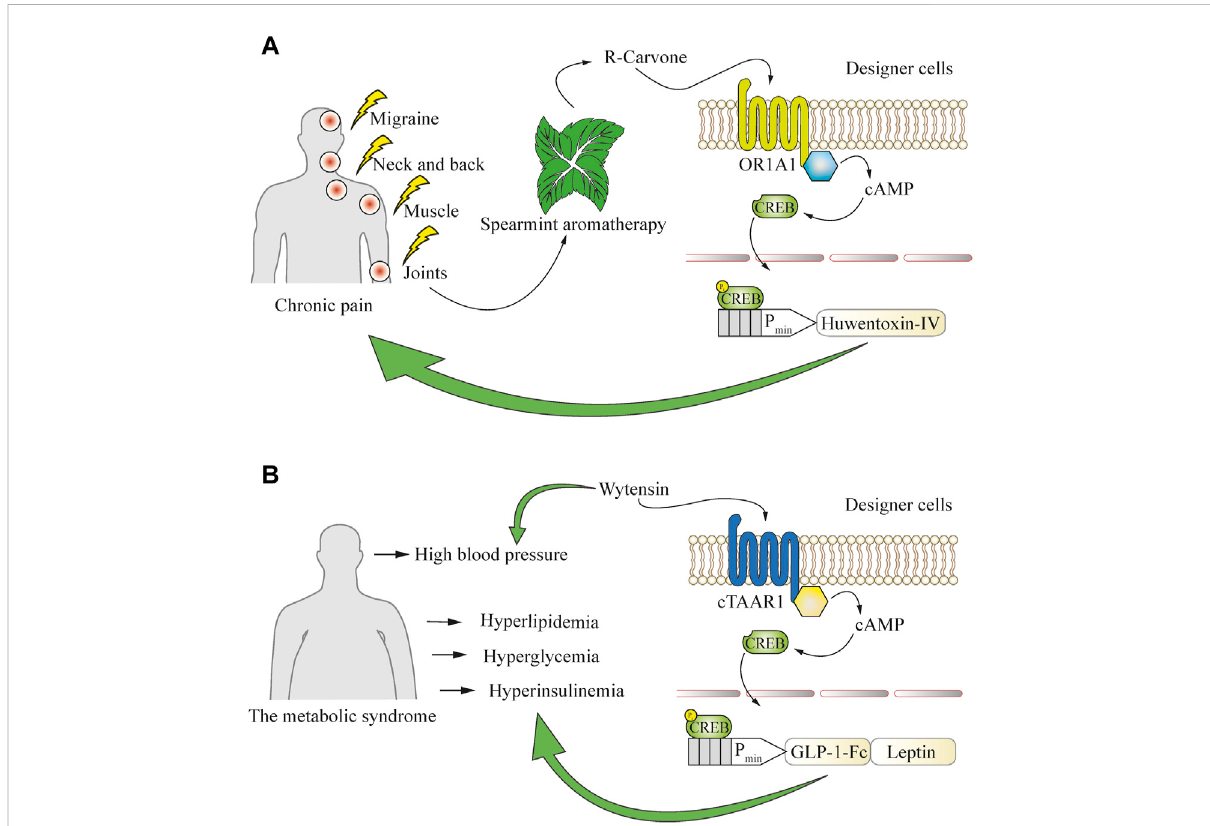
FIGURE 5 Using a de fi ned behavior to convert open-loop cellular systems into closed-loop circuits. (A) Application of aromatherapy for the treatment of chronic pain can be used to drive closed-loop production of an analgesic peptide that blocks the pain-conductive Na V 1.7 channels. Inhaled R-carvone, a volatile substance commonly found in spearmint aromatherapy, is used as a speci fi c activator of the OR1A1 GPCR in engineered cells. This receptor potently induces the cAMP pathway, which is then rerouted to a CREB-operated promoter for the production of huwentoxin-IV to boost the therapeutic effect of aromatherapy. (B) Engineered cells enable closed-loop combinatorial treatment of metabolic syndrome co- morbidities such as hyperlipidemia, hyperglycemia, hyperinsulinemia, and hypertension, which are often simultaneously present in patients. Oral intake of the anti-hypertensive drug wytensin speci fi cally activates cTAAR1 GPCR in engineered cells to enable the production of protein drugs addressing the co-morbidities. The cTAAR1 receptor potently induces the cAMP pathway, which is rerouted to a CREB-operated promoter for the production of engineered GLP-1 to treat hyperglycemia and hyperinsulinemia, and leptin to address